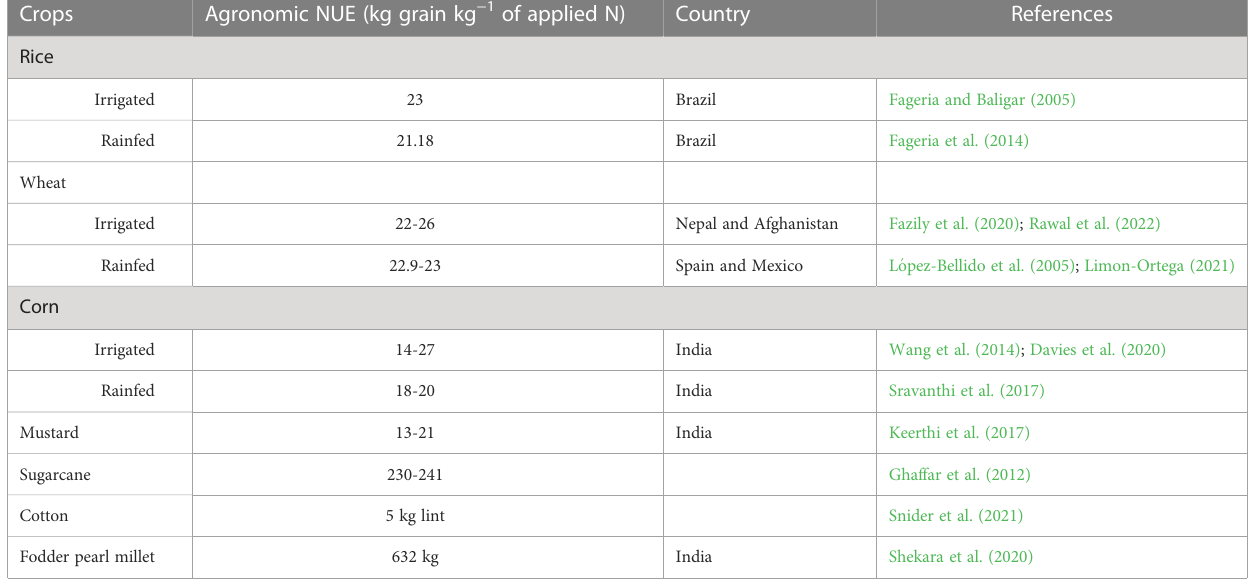
TABLE 2 Agronomic NUE of various fi eld crops in the world.